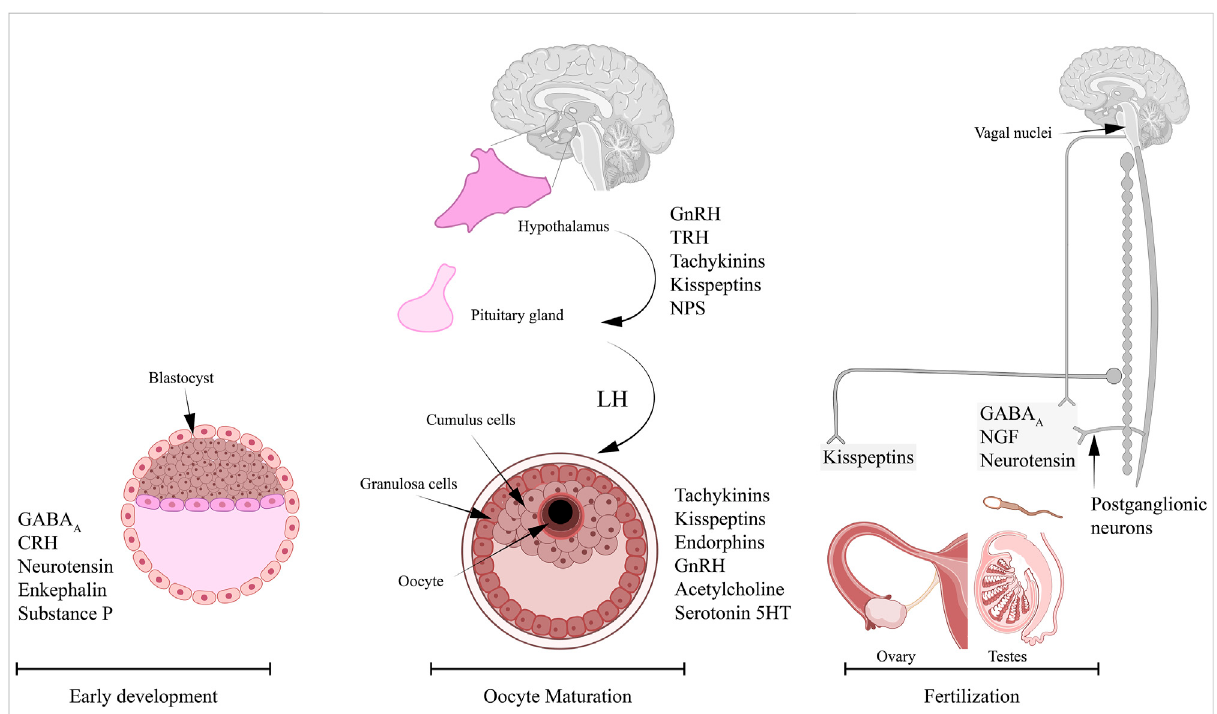
FIGURE 1 Neurotransmitters and neuropeptides reported to play roles in reproductive processes and dependent on Ca 2+ signaling. Several studies in vertebrates and invertebrates reported important role for speci fi c neuropeptides in oocyte maturation, sperm activity, and embryogenesis. The neurotransmitters and neuropeptides reported to play an important role in oocyte maturation and involve Ca 2+ signaling include: tachykinins, kisspeptins, endorphins, GnRH, acetylcholine, and serotonin, 5-HT. The innervation of ovaries is mainly through the nerves from the ovarian plexus. The neuropeptidesthat are known to regulatesperm activity in aCa 2+ -dependentmechanism include: GABA A , neurotensin (NT), and NGF. It ispossiblethatthese neuropeptidesarereleasedbytheinferiorandsuperiorspermaticnervesthatinnervatethetestis.Thelistofneuropeptidesthat were associated with early development and involve Ca 2+ signaling are: GABA A , NT, enkephalins, substrate P, and corticotropin-releasing hormone